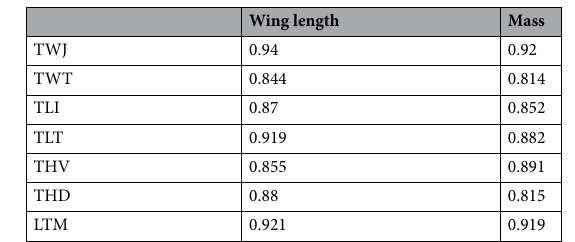
Table 7. Pearson’s product-moment correlation coefficient ( r ) between the average wing length and mass, and measurements of seven syringeal structures. TWJ = posterior tympanum width, TLJ = posterior tympanum depth; TWT = anterior tympanum width, TLT= anterior tympanum depth; THD and THV = medial height of the tympanum dorsally and ventrally; LTM = width of lateral tympaniform